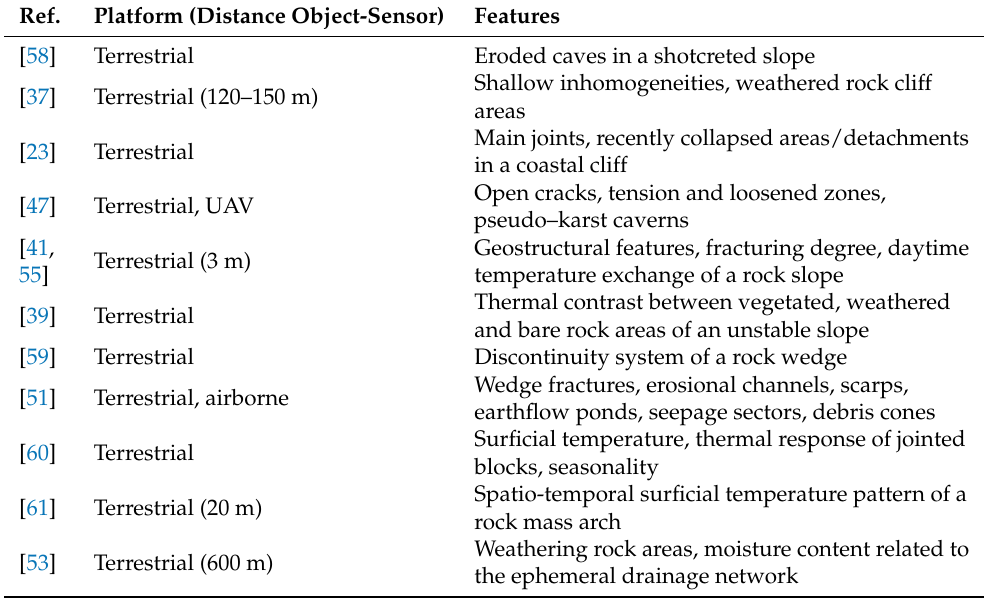
Table 1. Features investigated by IRT in recent studies.